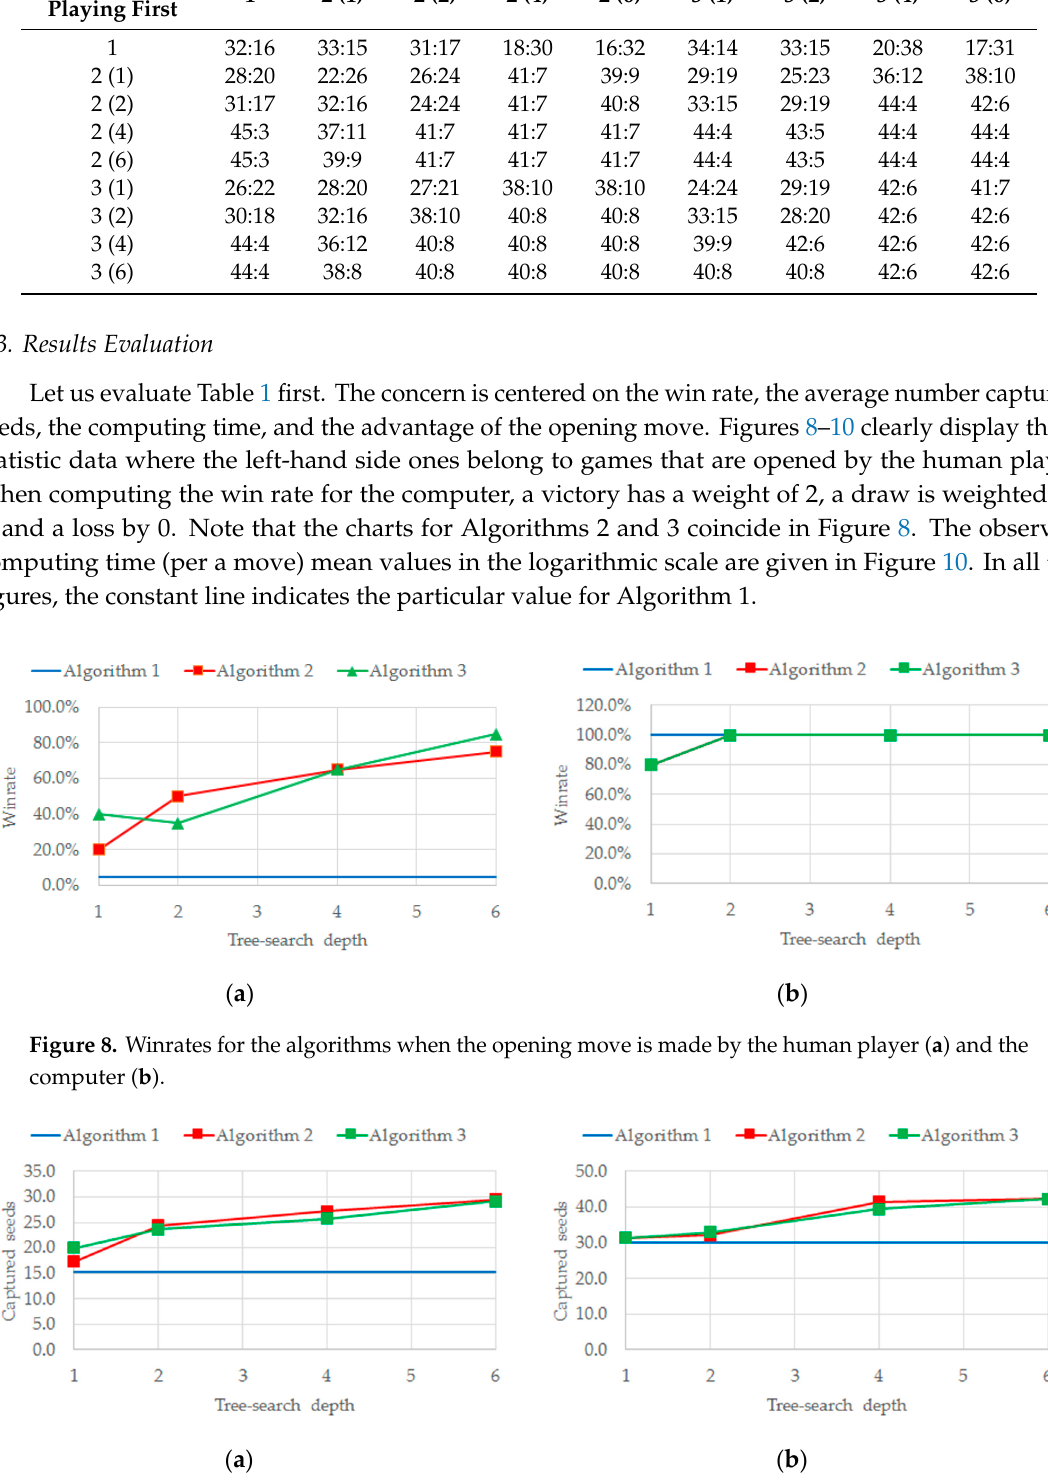
Table 2. Results of the round-robin tournament of the algorithms. Algorithm Playing First